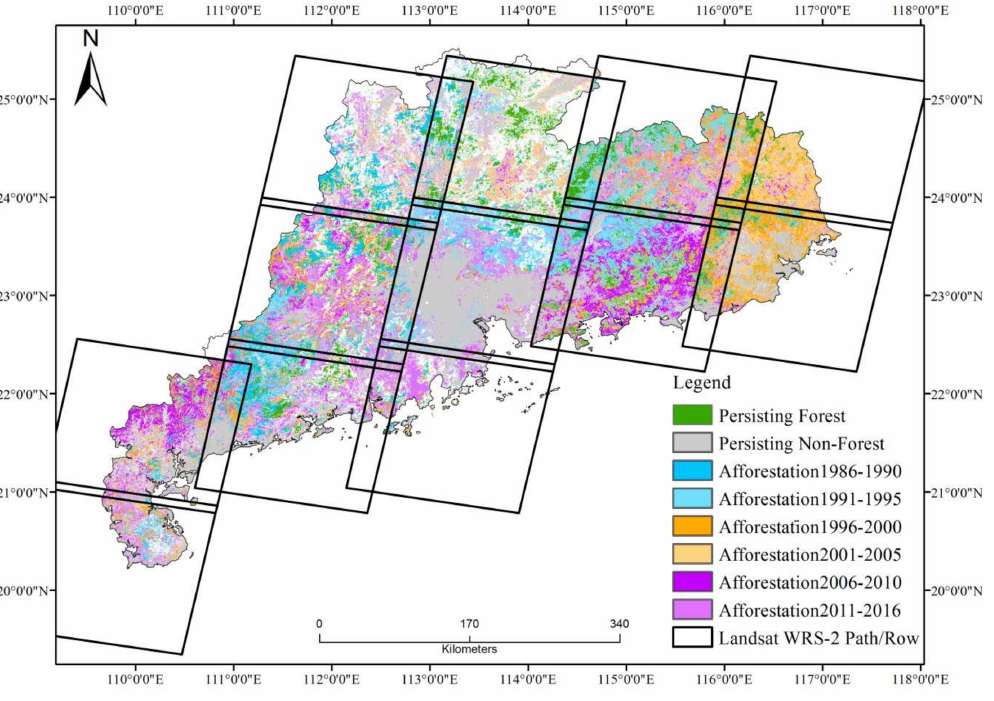
Figure 9. Forest change mapping (afforestation) over Guangdong Province.